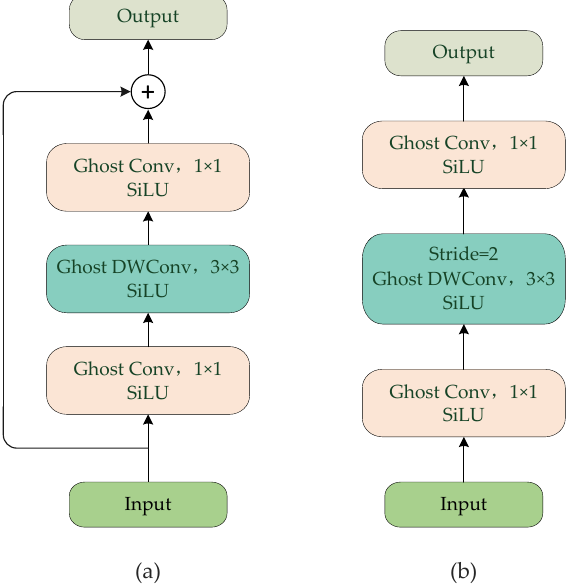
feature extraction capability. suring the